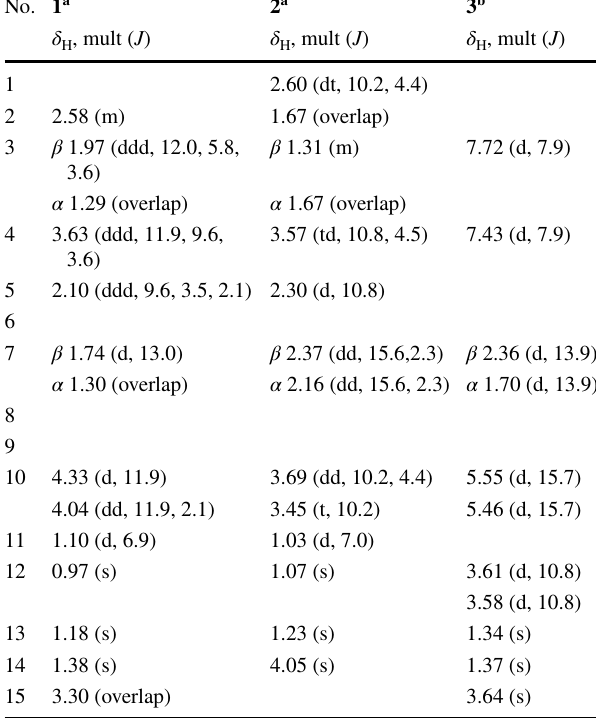
Fig. 1 Chemical structures of compounds 1 – 3 Table 1 1 H NMR data ( δ in ppm, J in Hz) of compounds 1 – 3